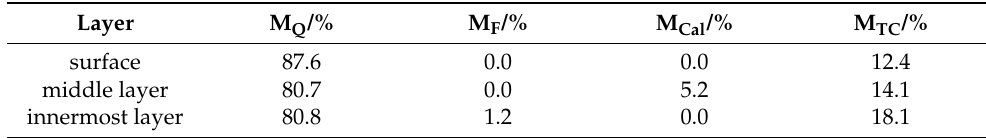
Table 10. Mineral content of sandstones in each